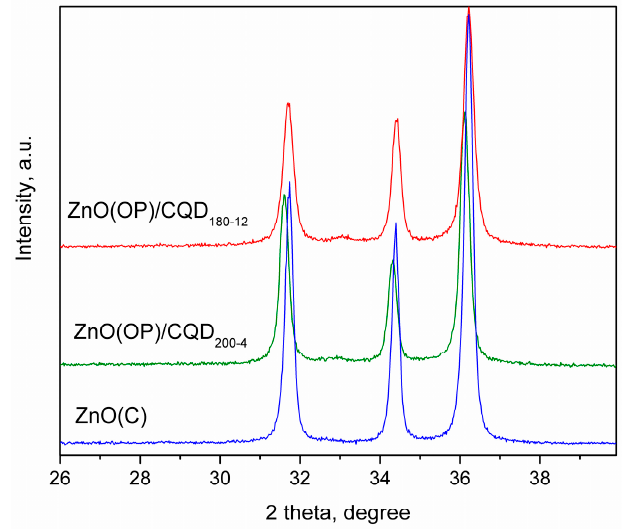
Figure 6. XRD patterns of on 2 θ = 30–38 ◦ of ZnO(OP)/CQD samples. The lattice parameters ( a, b and c ) were calculated using Equation (2), while the plane d-spacing ( d ) was calculated using the Braggs’ Equation (3) [47]: